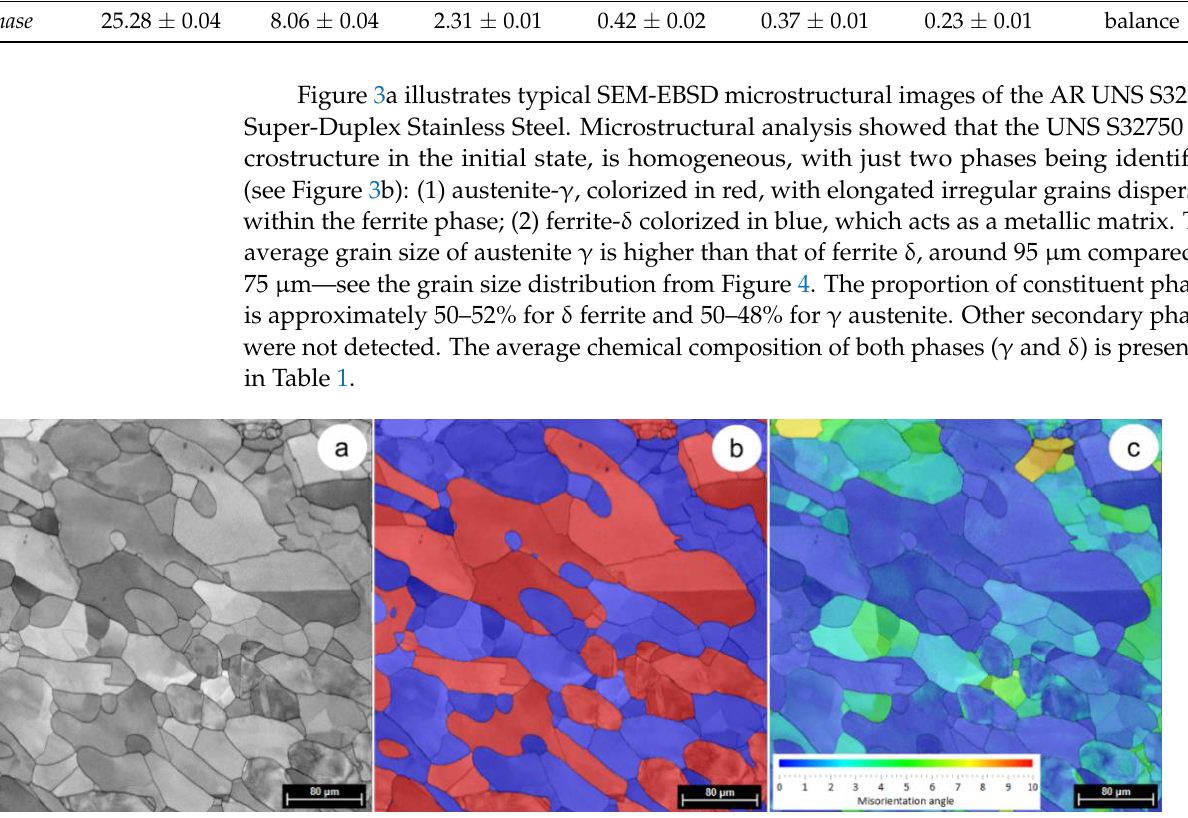
Figure 3. Typical SEM-EBSD microstructure images of AR UNS S32750 Super-Duplex Stainless Steel ( a ); distribution map of constituent phases (γ-phase—red colorized and δ-phase—blue colorized) ( b ); GROD distribution map for both γ-phase and δ-phase ( c ).